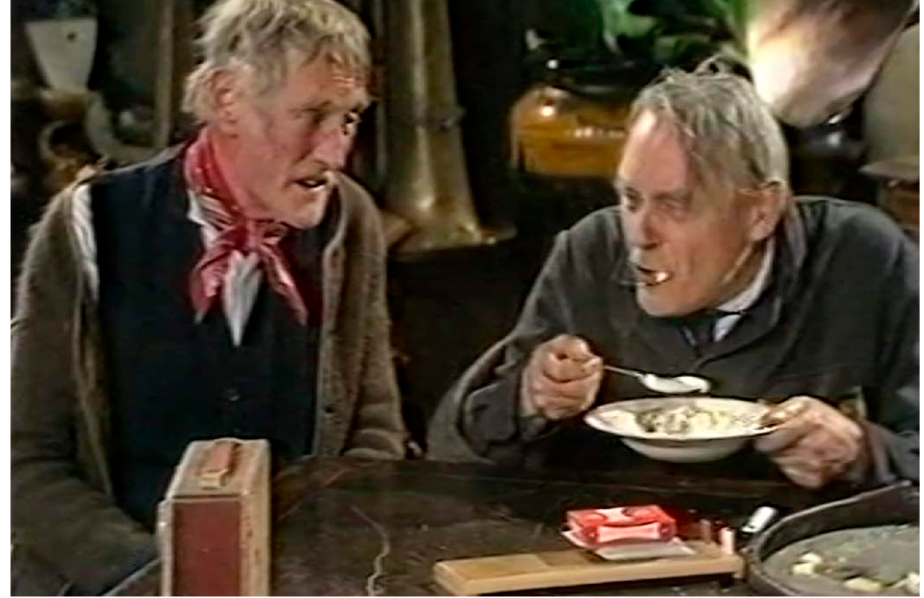
Figure 3. Frank enjoys Albert’s lumpy porridge.